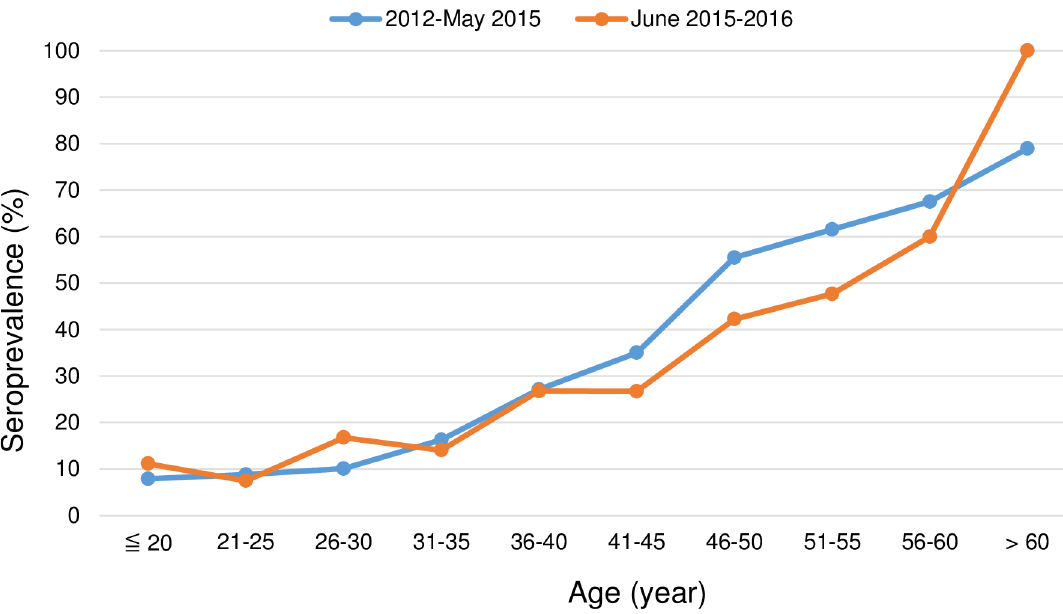
Fig 3. Comparisons of hepatitis A virus seroprevalence according to age-specific groups in the 2012–2016 cohort during the non-epidemic (2012—May 2015) and epidemic (June 2015–2016)period.